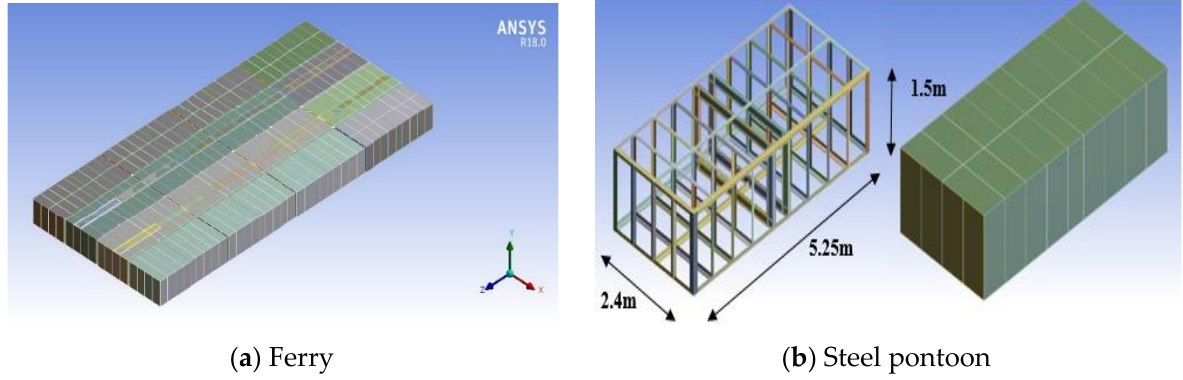
Figure 2. Schematic illustrating the ferry and steel pontoon configuration.